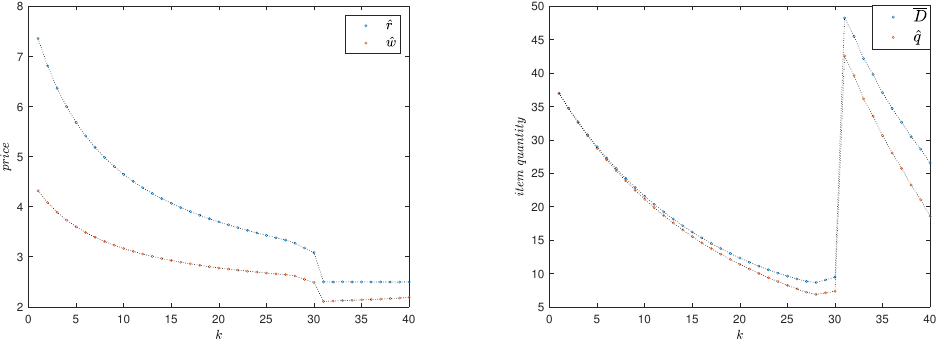
Figure 4. Market with strategic customers: pricing and supply quantities at equilibrium states